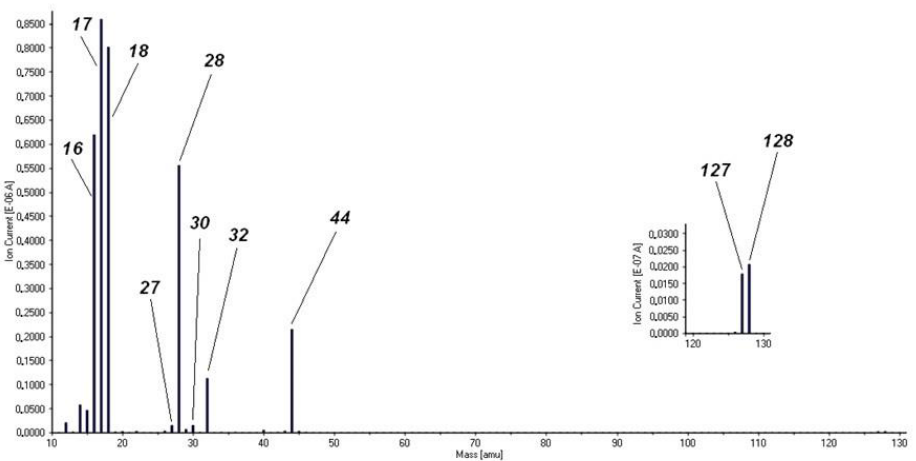
Figure 10. Analogous TG-MS spectra of the main gaseous decomposition products of compound 1 (please note that the numbers are representing m / z data).